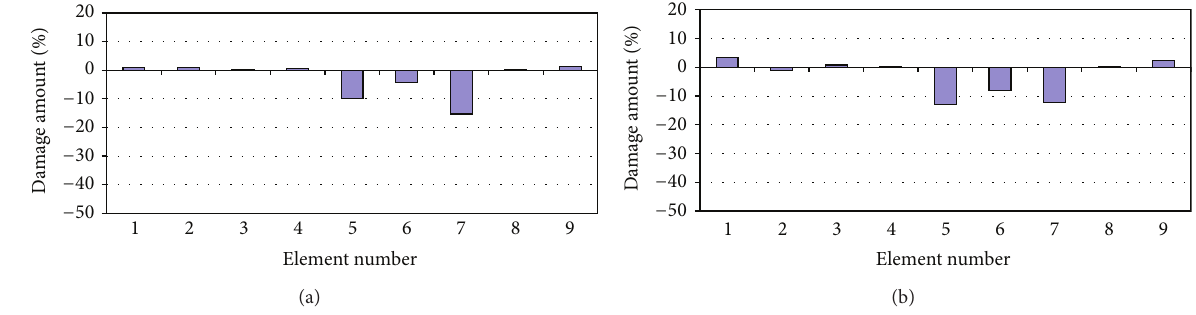
Figure 8: Inverse damage predictions for 𝐹 1 = 10 kN, (a) 5 experimental frequencies for damaged structure used, and (b) 8 experimental frequencies for damaged structure used.